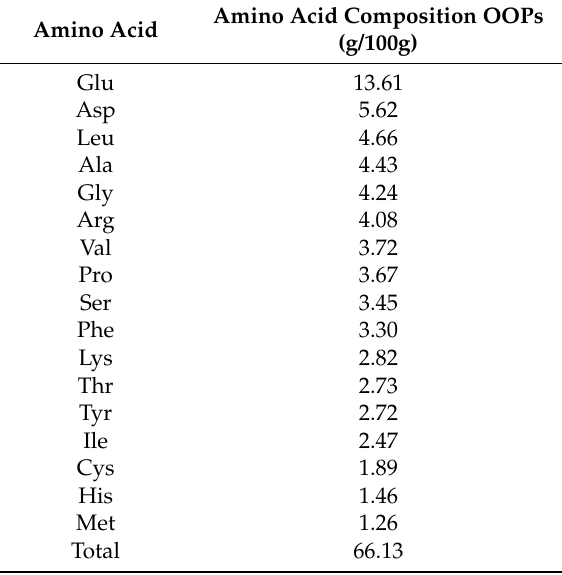
Table 8. Amino acid composition of oat